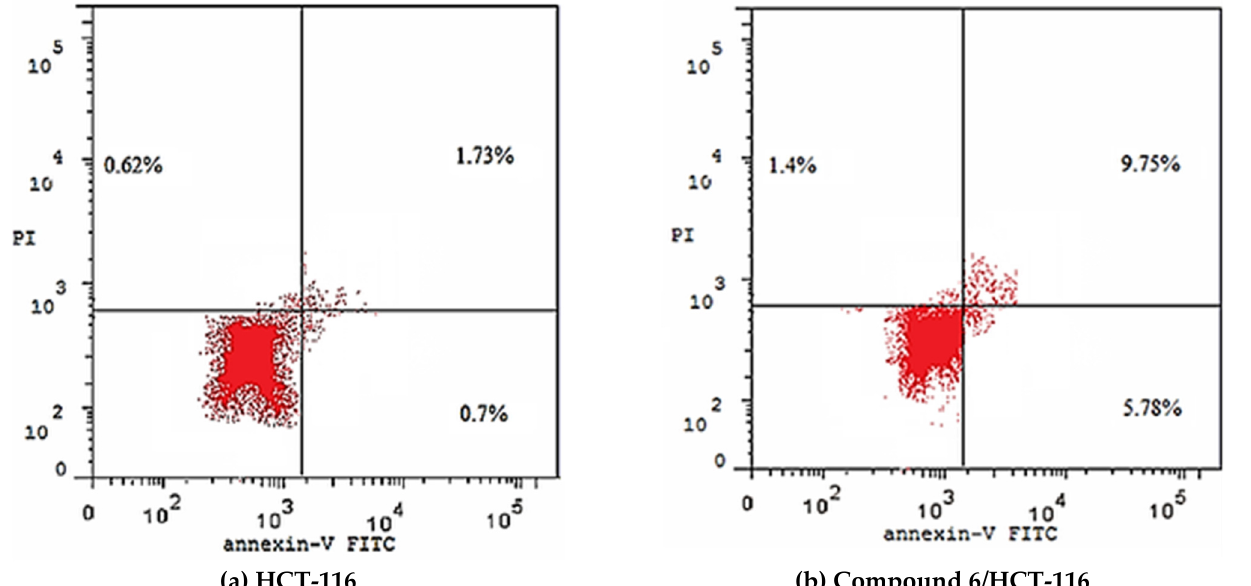
Figure 4. Induction of apoptosis by of HCT-116 cells after treatment with 9.3 µ M of compound 6 for 48 h. ( a ) is the control test, ( b ) is the treated cells. Compound 6 increased the early and late apoptosis from 0.7% and 1.73% in the control cells to 5.78% and 9.75% in the treated cells. Table 4. The inhibition (%) of TNF- α and IL6 in HCT-116 cells after compounds’ 6 and 7 treatment.